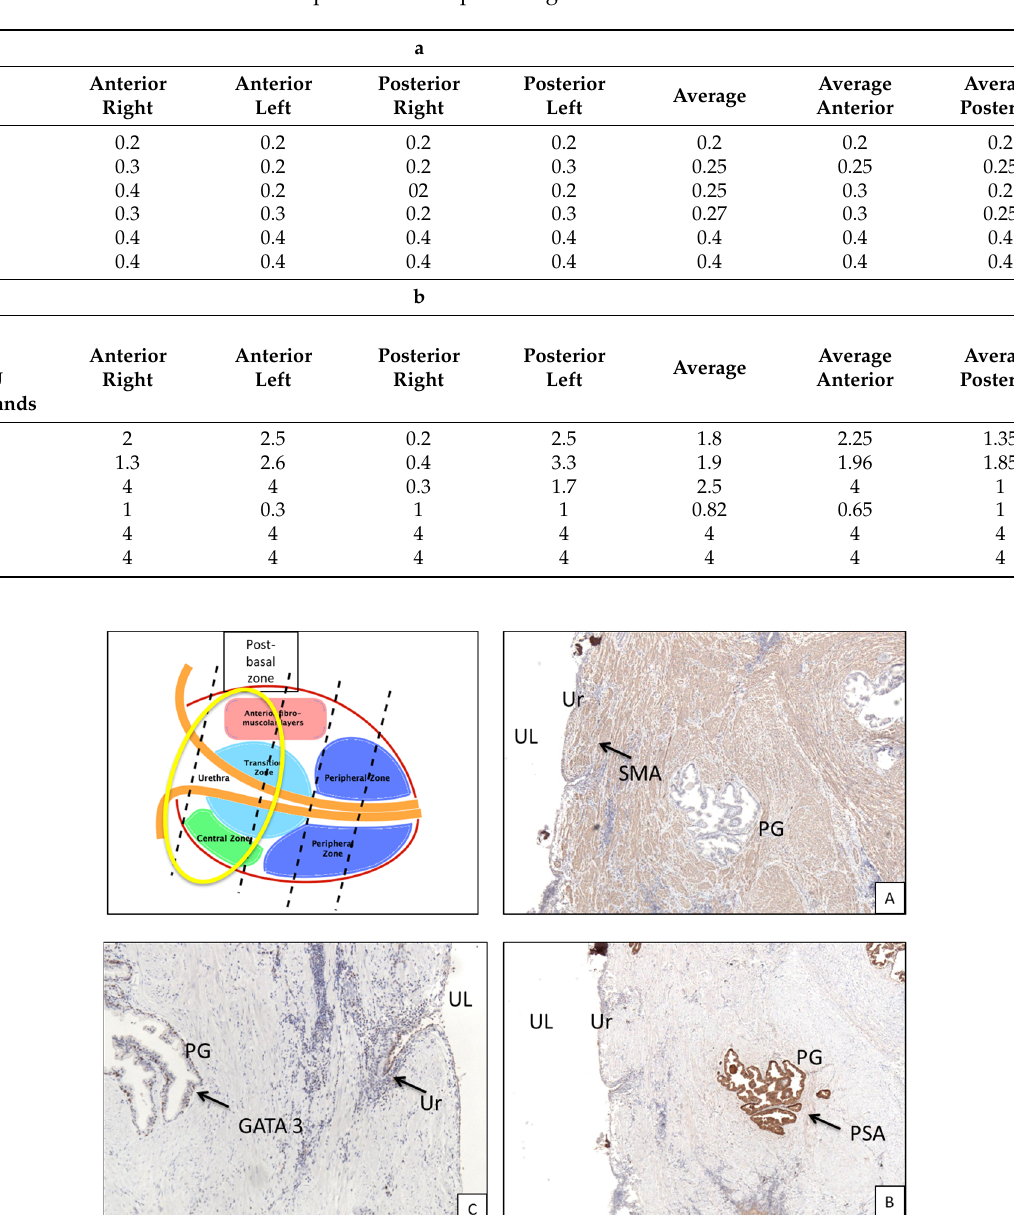
Table 2. a. Chorion thickness at the level of the basal portion of the PU. b. Distance between basal membrane of the PU epithelium and prostate glands at the level of the basal PU.